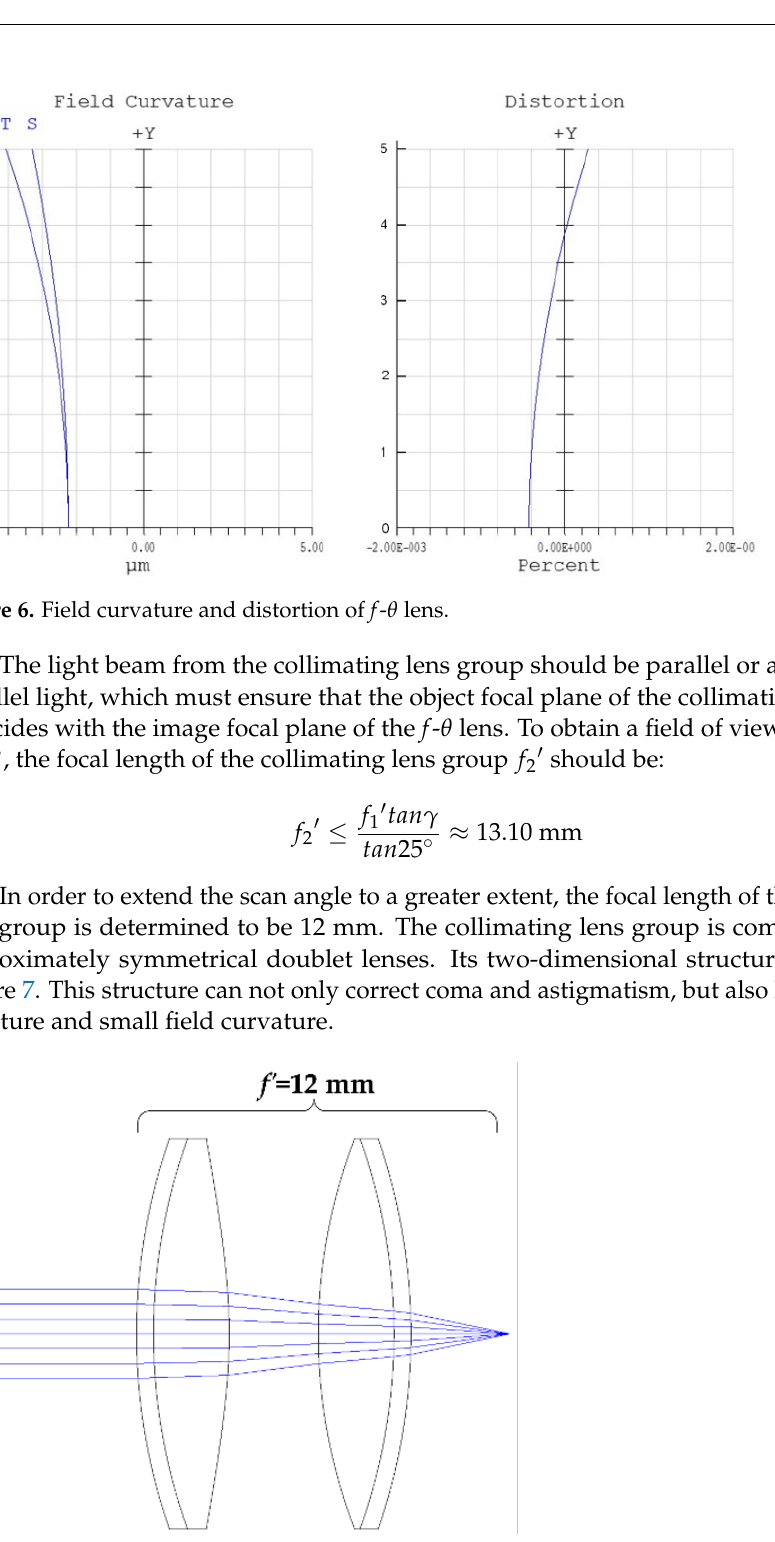
Figure 7. Two-dimensional structure diagram of symmetrical cemented lens group. Combining the doublet lens L 0 , f - θ lens L 1 , common mirror, MEMS mirror, and collimating lens group L 2 to complete the overall system design. The three-dimensional structure of the large-angle MEMS scanning optical system is shown in Figure 8. The parameters related to the design are listed in Table